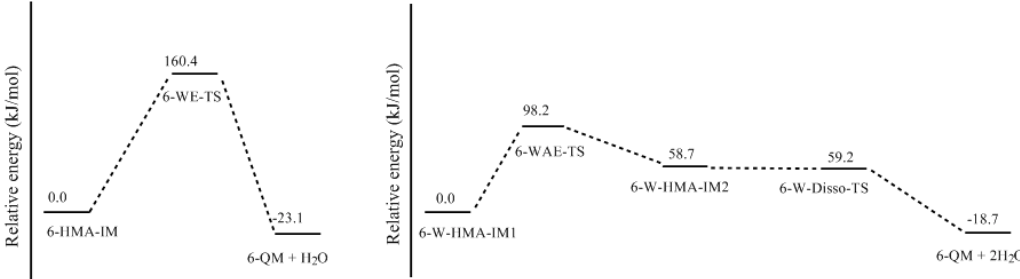
Figure 7. The potential energy profiles for formation of 6-QM via the WE and WAE mechanisms.